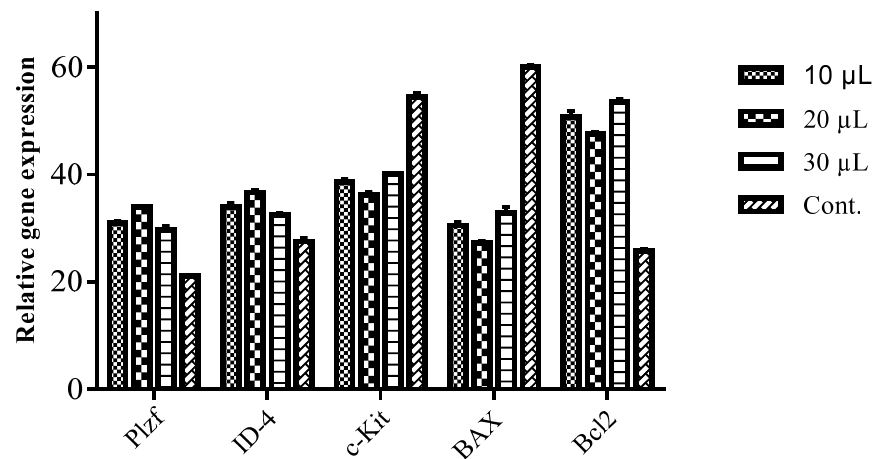
Figure 1. Expression patterns of Plzf , ID-4 , c-Kit , BAX , and Bcl2 genes after treatment with different amounts of T. ammi fruit oil (10, 20, and 30 µL). Expressions of Plzf and ID-4 were increased after treatment with oil, while the expression of c-Kit was decreased. Expression levels of BAX and Bcl2 were decreased and increased after treatment, respectively. Stars show significant differences between treatment groups and the control group ( p < 0.05).